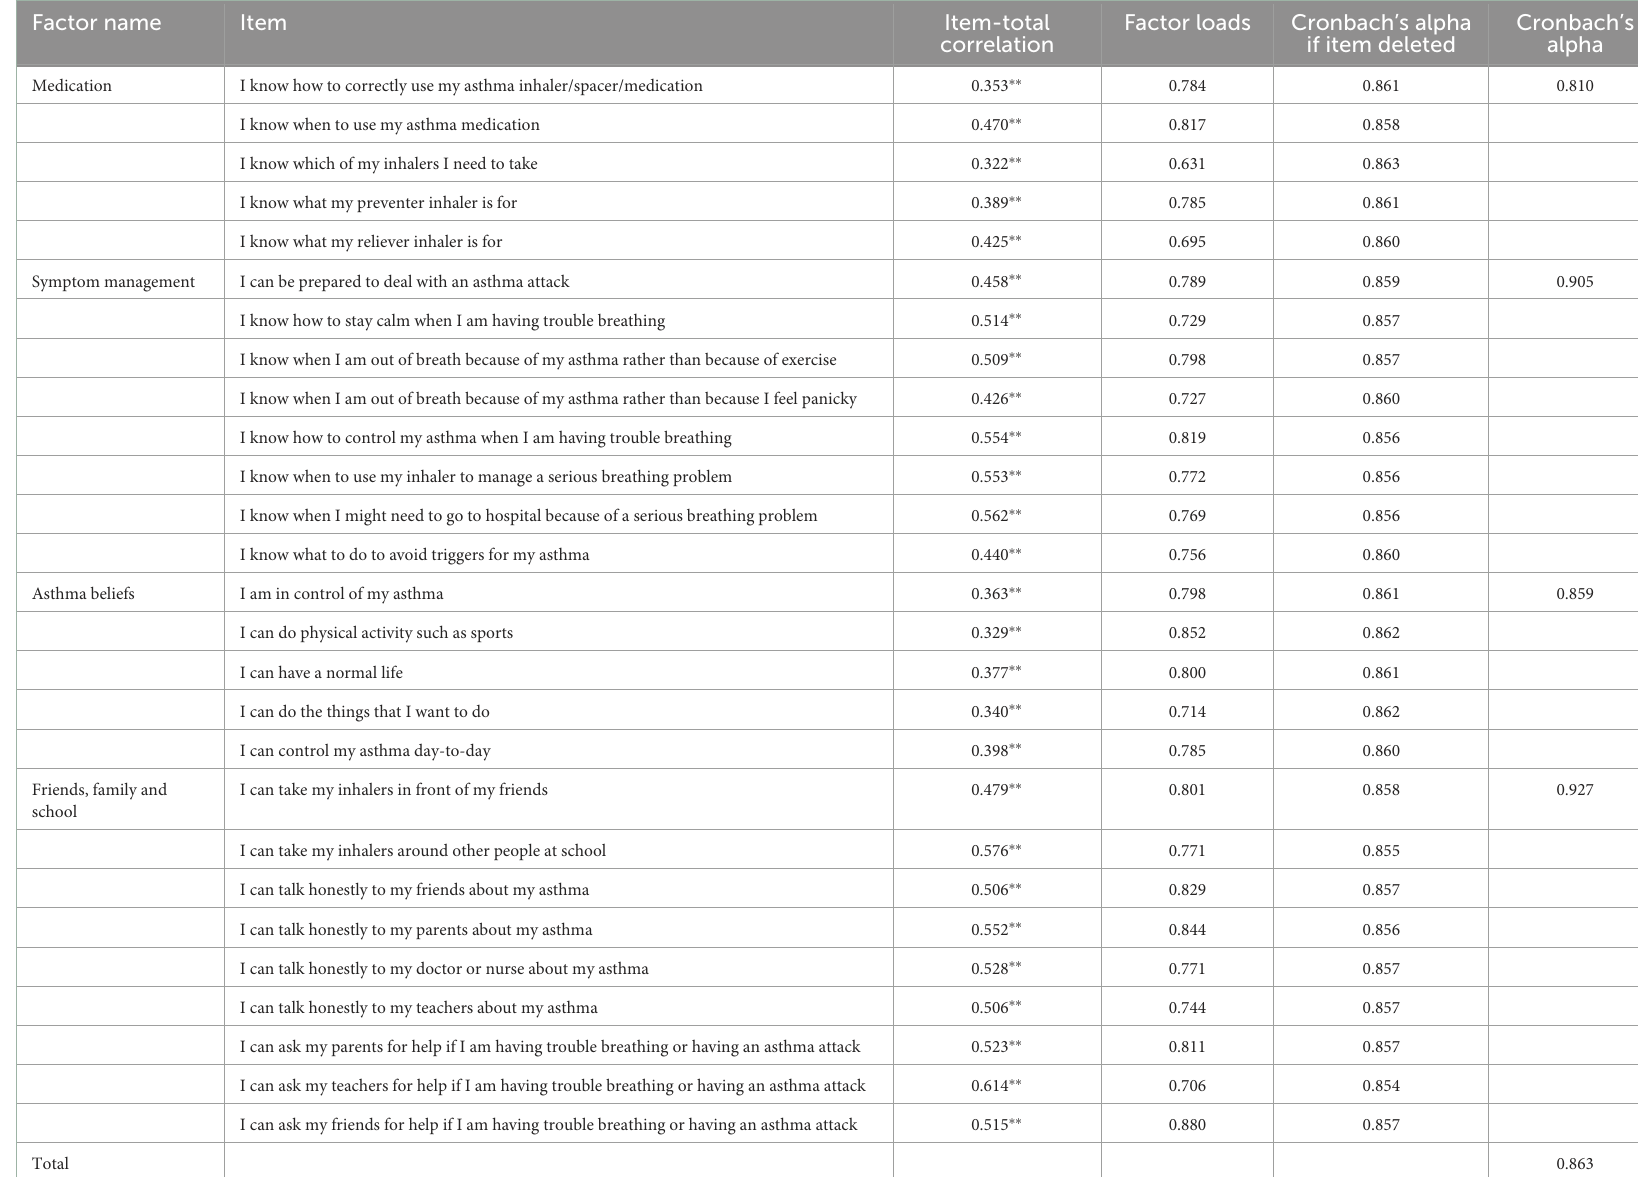
TABLE 2 Item-total correlation, reliability coefficients, and factor loads of the Chinese Adolescent Asthma Self-Efficacy Questionnaire (C-AASEQ; N = 234). Factor name Item Item-total